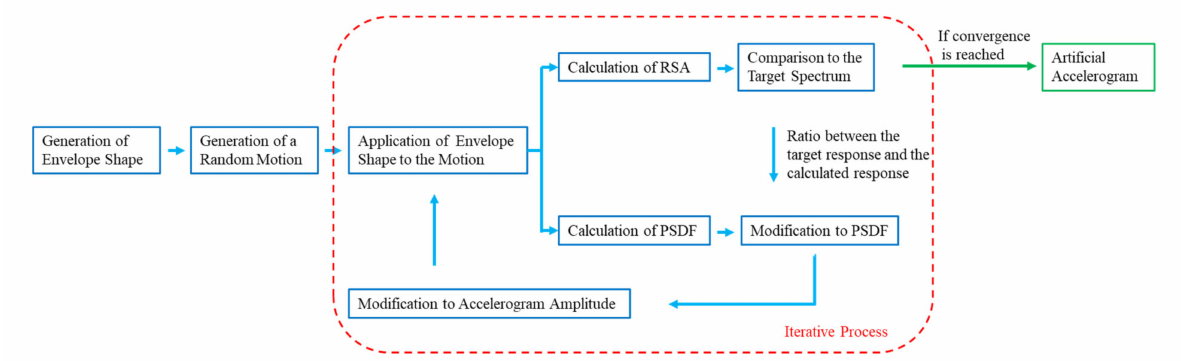
Figure A2. Schematic summary of the artificial accelerogram generation method. Simulation of the artificial accelerograms can be based on the assumption of non- stationary behavior of the frequency properties of the ground motion. The non-stationary behavior of the ground motion amplitude is defined by the envelope function in the time do- main. The envelope function recommended by Saragoni and Hart [56] is described below. (1) Duration. Duration is function of magnitude and distance and is estimated as the sum of “source” and “distance” durations [57–59]. Expressions for calculation of the total duration are presented in Equations